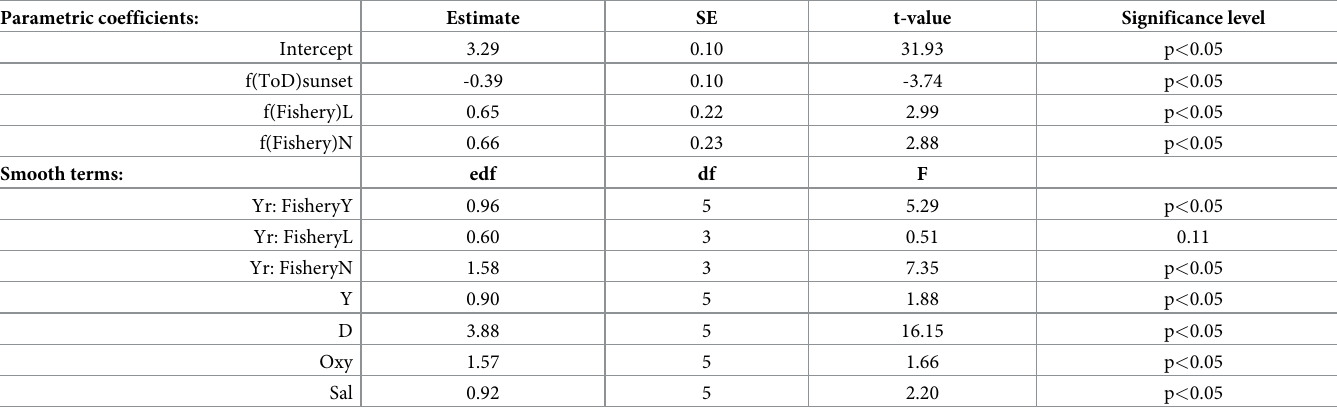
Table 2. Summary of the outputs of the final GAM for the biomass index (kg/km 2 ). Explanatory variables included the single effect of factor Time of the Day (ToD) and Fishery, Year-Fishery interaction (Yr:Fishery) for each level of the factor (“Y” fishery allowed, “L” limited fishery, “N” fishery ban), longitude (Y), depth (D), percent- age of dissolved oxygen (Oxy) and salinity (Sal); “SE”, standard error; “edf”, estimated degrees of freedom; “df”, degrees of freedom. Parametric coefficients: